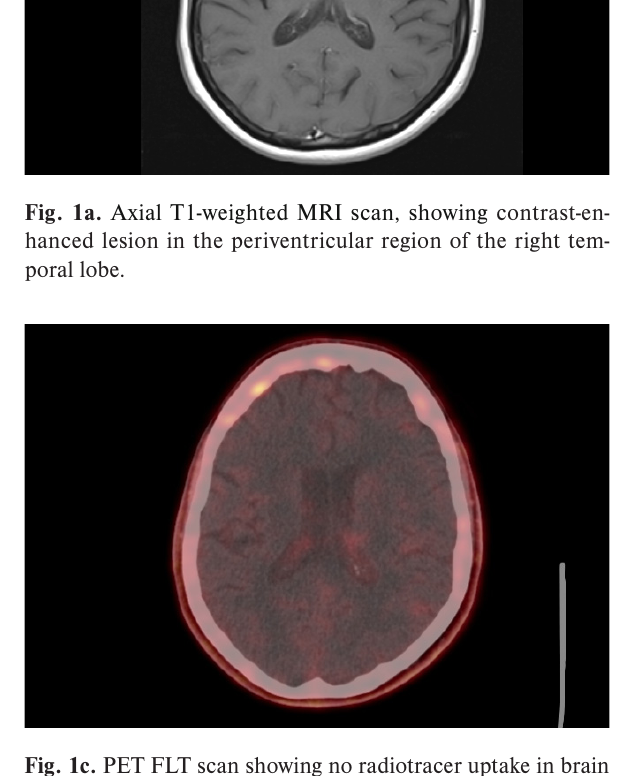
Fig. 1c. PET FLT scan showing no radiotracer uptake in brain tissue.